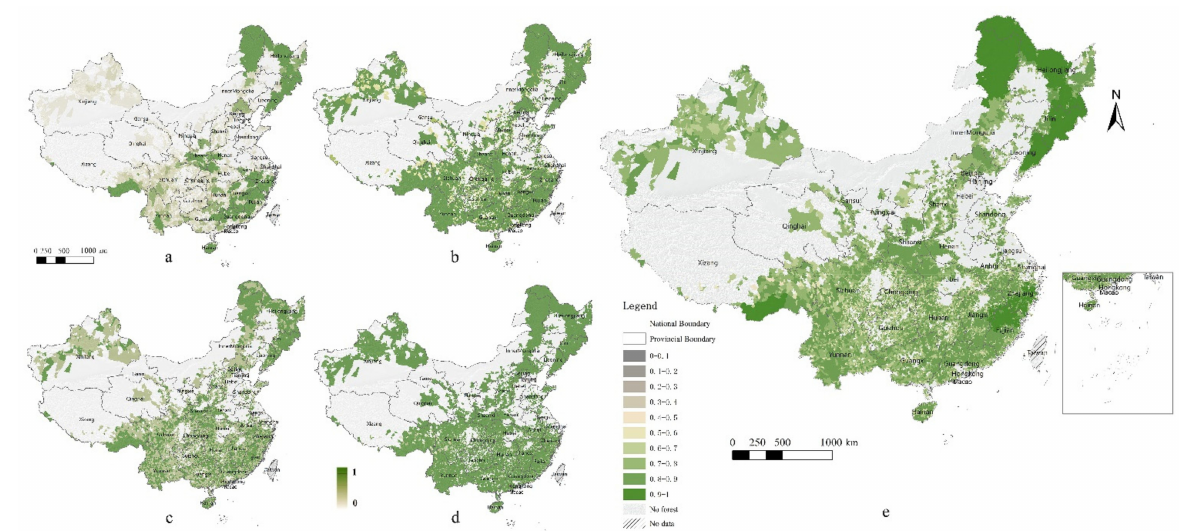
Figure 6. The sustainability evaluation results of the FR dimension. The evaluation results of ( a ) the forest patch area, ( b ) the forest canopy closure, ( c ) the forest type, and ( d ) whether the forest is a national protected area; ( e ) the DI of the FR dimension.